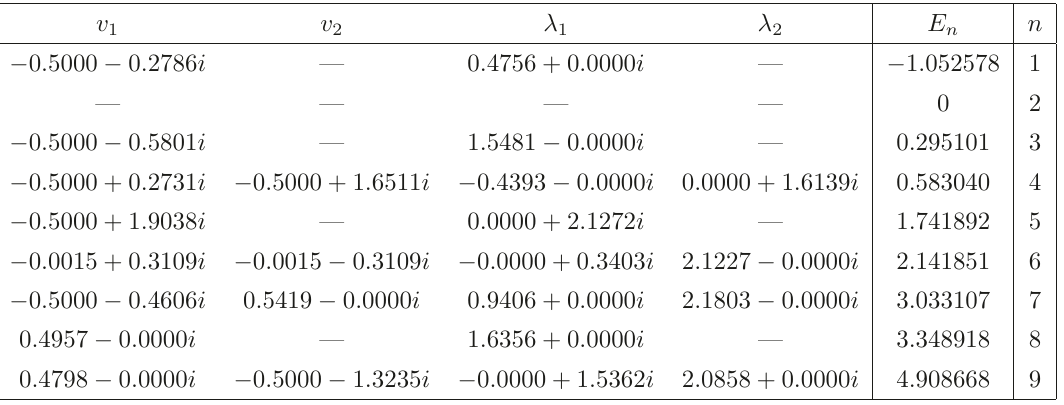
Table 1. Solutions of BAEs (2.24)–(2.25) for the case of L = 2 , η = 1 , ξ = 0 . 6 , θ = π/ 5 , φ = π/ 3 , ξ ′ = 1 . 5 , θ ′ = 2 π/ 3 , φ ′ = π/ 4. The symbol n indicates the number of the eigenvalues, and E n is the corresponding eigenenergy. The energy E n calculated from (2.26) is the same as that from the exact diagonalization of Hamiltonian (1.1).